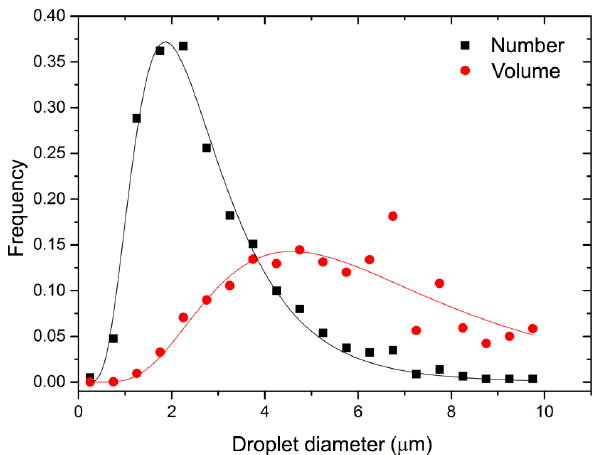
Figure 1. Normalized lognormal size distribution of emulsion droplets. Data points represent bin widths of 0.5µm. The parame- ters for the lognormal number distribution are d m = 2 . 41 ± 0.04µm and w = 0 . 507 ± 0.014, and for the volume distribution d m = 6 . 1 ± 0.4µm and w = 0 . 53 ±